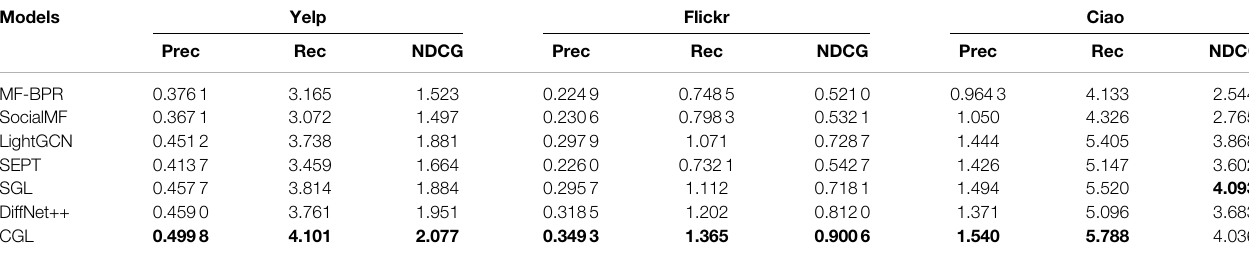
TABLE 3 | Overall comparison ( K = 15). The best results are in bold. Models Yelp Flickr